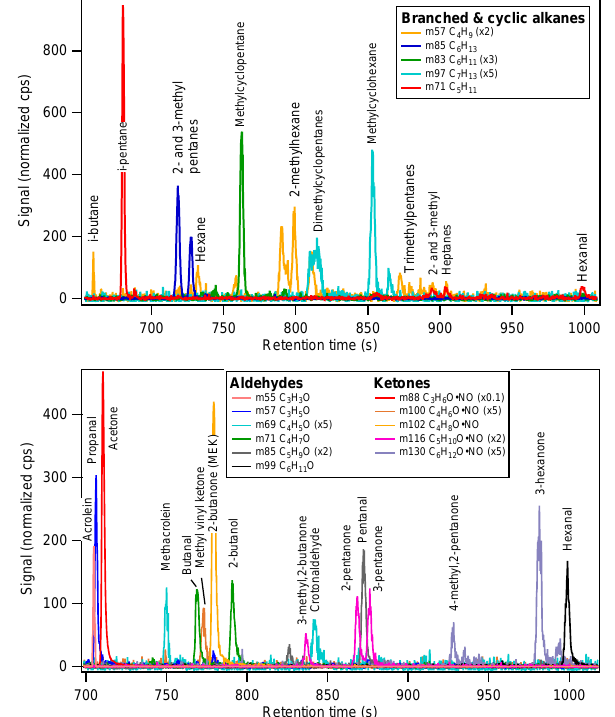
Figure 8. Example GC-CIMS chromatogram of ambient air sample. Masses have been split between two panels for clarity. Top: select masses corresponding to branched and cyclic alkanes. Bottom: se- lect masses corresponding to aldehydes and ketones.